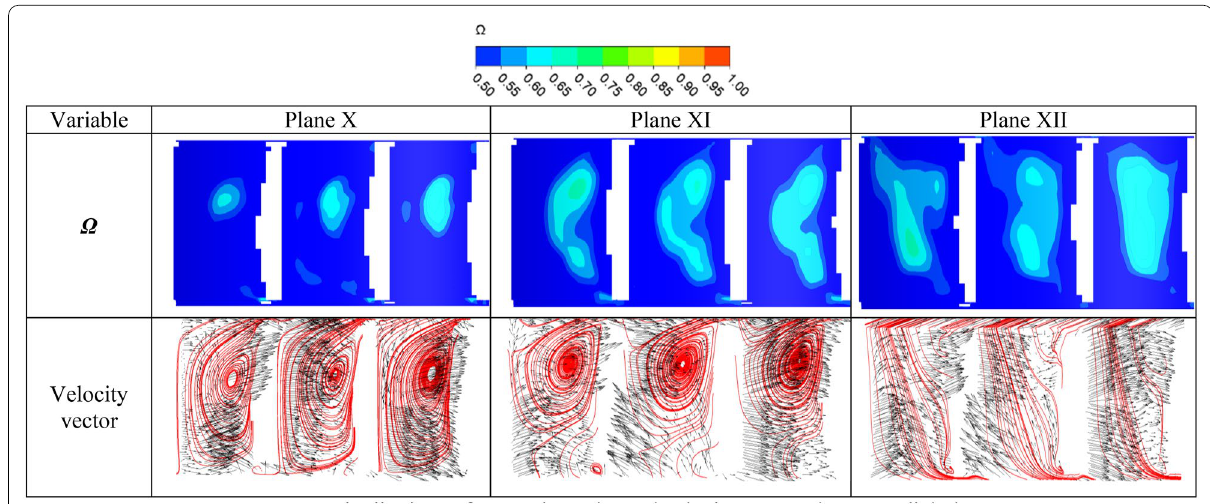
Figure 15 Distributions of vortex intensity and velocity vector plots on radial